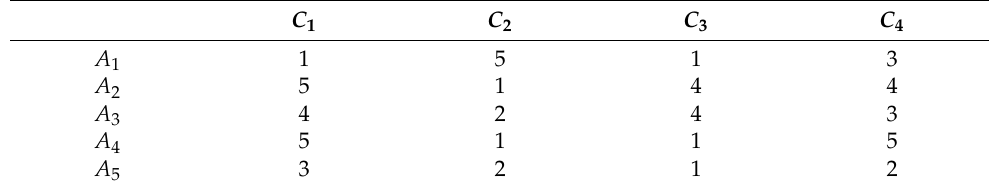
Table 1. The first of four selected initial decision-making matrices.